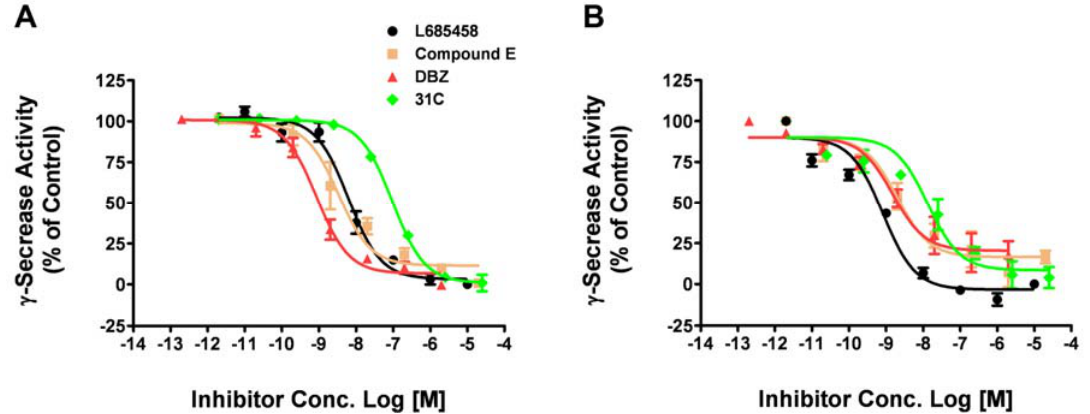
Figure 4. Dose-response curves of known inhibitors against drosophila and mouse